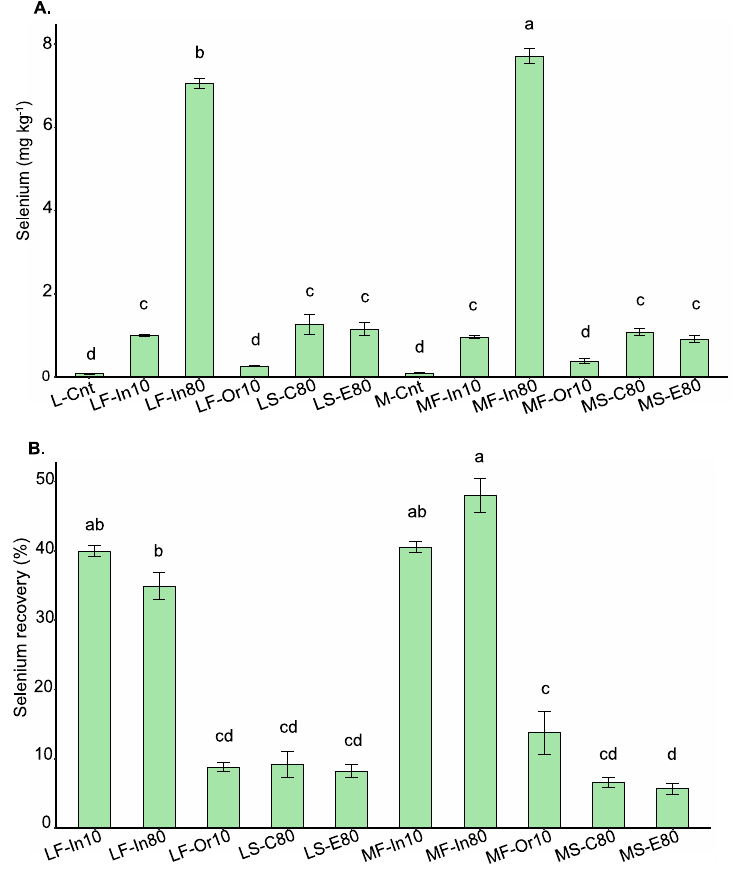
Figure 1. Selenium content (mg kg − 1 ) ( A ) and selenium recovery (%) ( B ) in soybean grains from biofortified plants growing under different methods of selenium application. Lowercase letters compare Se contents and Se recovery among the treatments at the level of 5% by the Tukey test. The vertical bars represent the standard error ( n = 4). Genotype: L = Lança and M = M5917; Se application: F = foliar and S = soil; Se source: In = Se inorganic, Or = Se organic, C = C-MAP + Se, and E = E-MAP + Se; Rate: 10 = 10 g ha − 1 and 80 = 80 g ha − 1 ; Cnt = control. The percentages of Se species found in soybeans are shown in Figure 2A. Selenium species in soybeans were influenced by the treatments applied ( p ≤ 0.05) (Table S1). For SeCys, the percentages ranged from 0.97% (MS-E80) to 17.0% (L-Cnt). The overall percentage of MeSeCys did not differ statistically among the treatments. In general, the Se species with the lowest percentages were MeSeCys and selenite. The highest average percentages for selenite species were found in the LF-In80 treatment (2.3%), yet this treatment differed only from the M-Cnt. The Se species found in the highest percentage in the grains was SeMet, which ranged from 54.0% (L-Cnt) to 94.1% (LF-In80). The LF-In80 treatment had the highest SeMet mean (94.1%); however, it differed statistically only from the LF-Or10 and M-Cnt. Organic Se